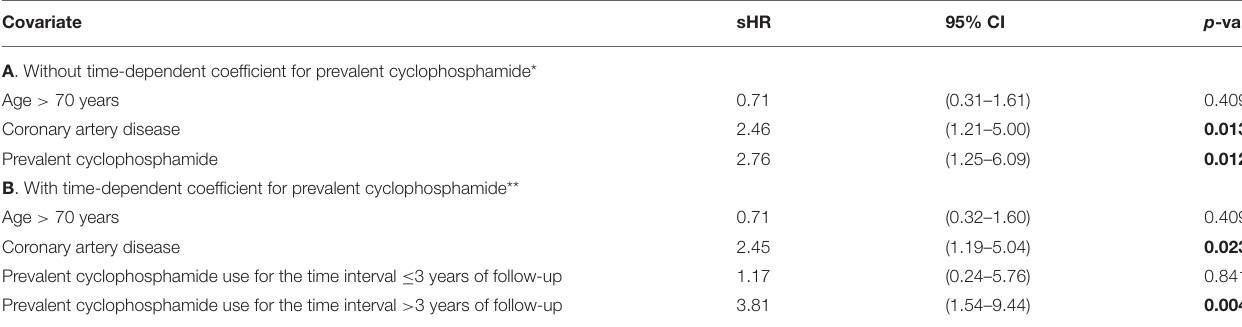
TABLE 3 | Multivariable Fine-Gray model, aortic stenosis progression as an event of interest. Covariate sHR 95% CI p -value